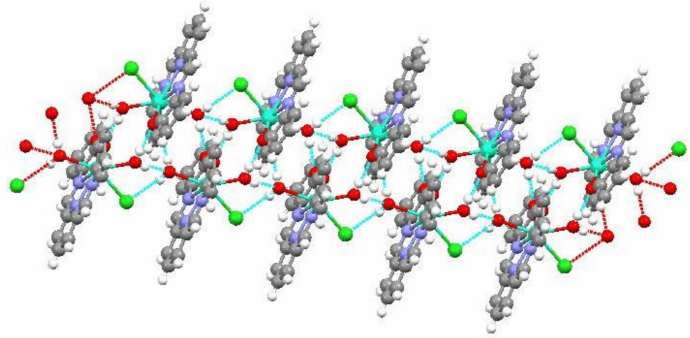
Figure 2. Hydrogen bond scheme for 1 , showing the zig-zag chain